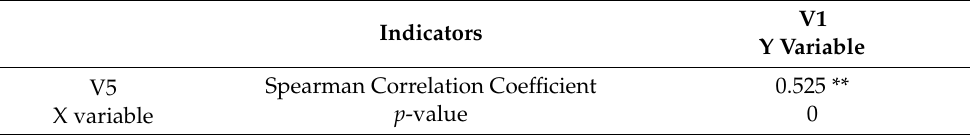
Table 15. The correlation between the familiarity with communication methods (V1) and easiness of participation